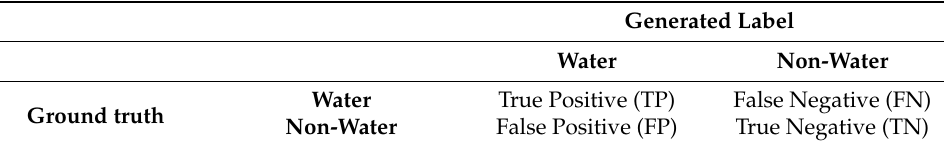
Table 5. Confusion